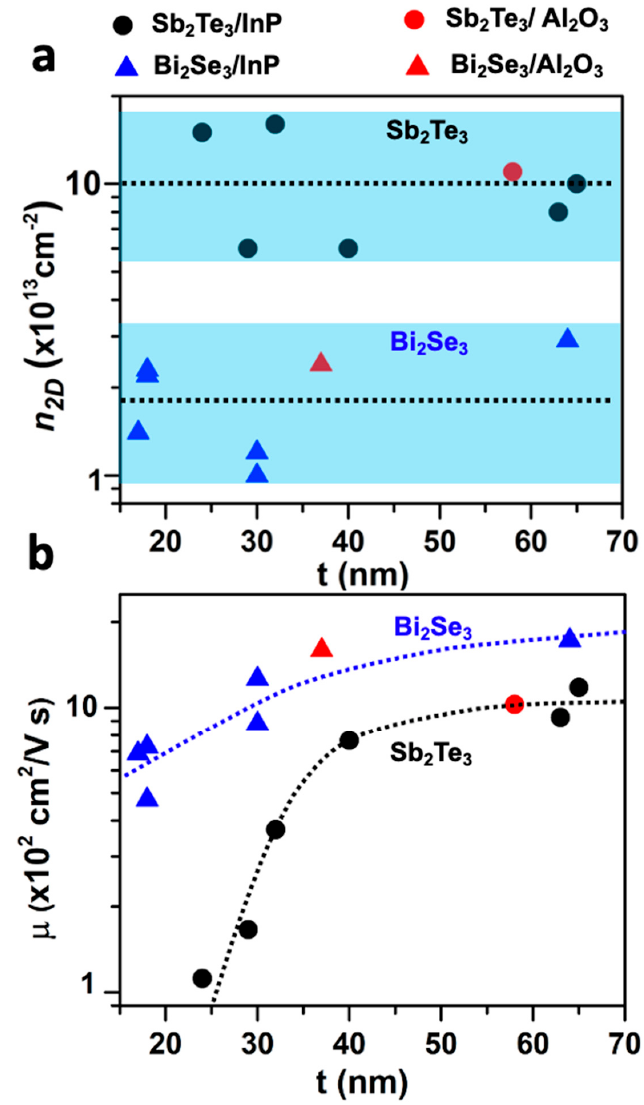
Figure 7. ( a ) 2D carrier density and ( b ) carrier mobility of Bi 2 Se 3 and Sb 2 Te 3 on In 2 Se 3 /InP(111)B as a function of film thickness. The red circle and the triangle are representative values of films grown on Al 2 O 3 for film thickness of 37 nm Bi 2 Se 3 and 58 nm Sb 2 Te 3 , respectively. Measurements are taken at 10 K.